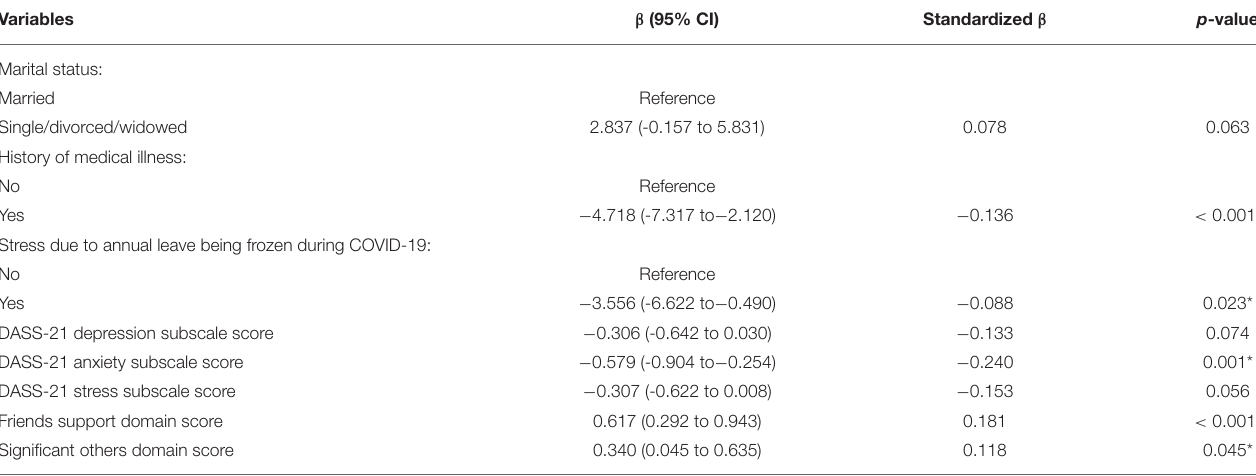
TABLE 3 | Multiple linear regression analysis with backward selection method between demographic and personal characteristics, COVID-19 related factors, psychological characteristics, perceived social support, and physical health QoL among the respondents.